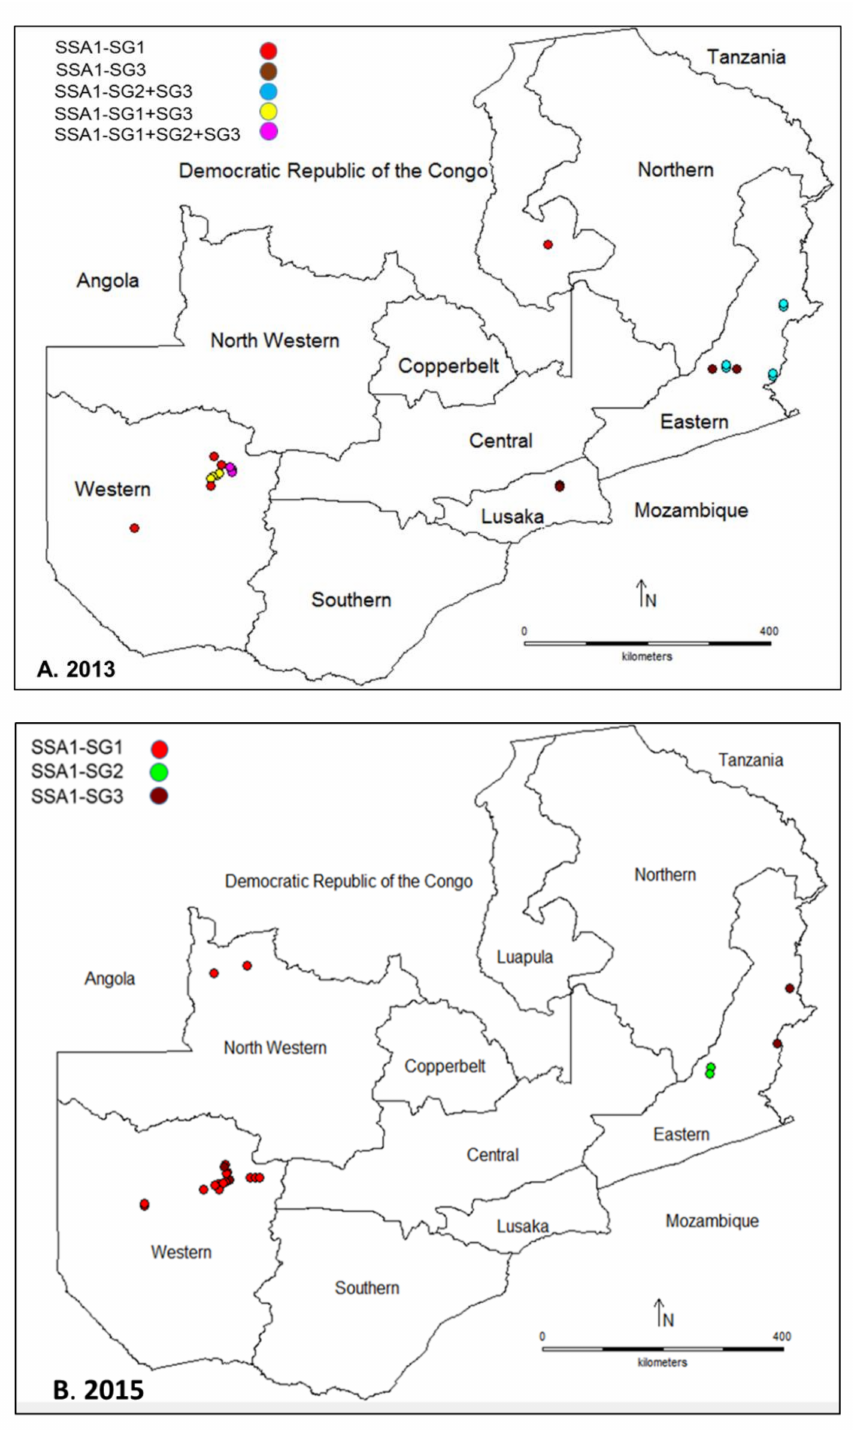
Figure 3. Distribution of Bemisia tabaci genetic groups sampled in Zambia. Each dot represents a site from which sampling was conducted and sequence obtained in ( A ) 2013 in Western, Luapula, Lusaka, and Eastern Provinces and ( B ) 2015 in North Western, Western and Eastern